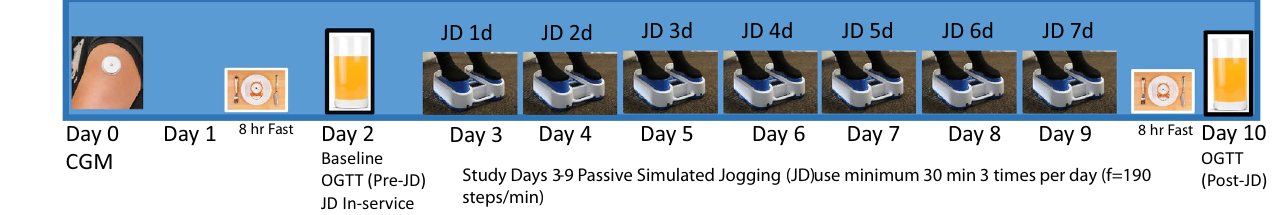
Figure 1. Study protocol. Continuous glucose monitor (CGM) was applied to the non-dominant arm on entering in the study (Day 0). Participants were asked to fast for 8 h prior to the initial baseline oral